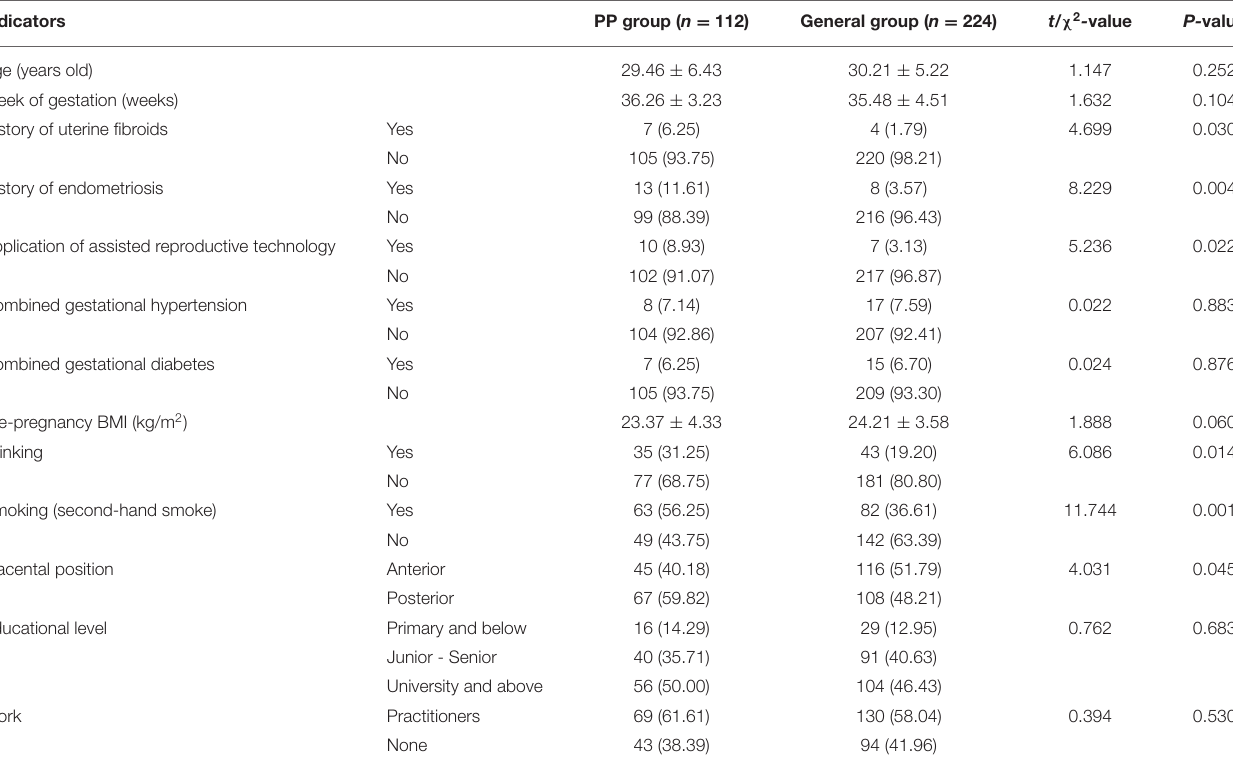
TABLE 1 | Univariate analysis of PP in first-time pregnant patients [mean, SD ( n , %)].